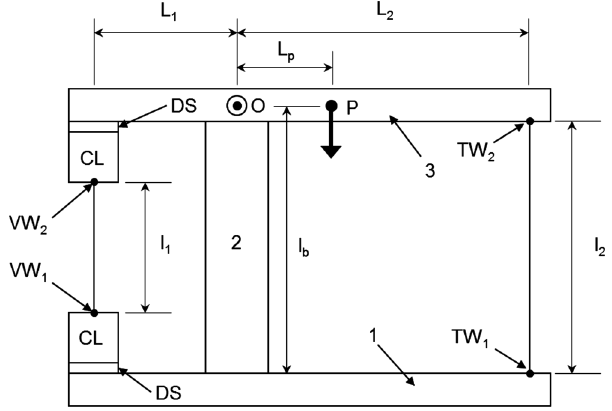
FIG. 2. Simplified drawing of the LA-VWM. 1: unmovable arm; 2: balancing arm support; 3: balancing arm. The thick arrow at point P denotes the direction of weight of the balancing arm applied to its center of gravity. The following notations are used in the text: l 1 : length of vibrating wire (distance between points VW 1 and VW 2 ); l 2 : length of target wire (distance between points TW 2 and TW 2 ); l b : length of balancing arm support (vertical distance between point TW 1 and balancing arm axis O); L 1 : horizontal distance between vibrating wire and point O; L 2 : horizontal distance between target wire and point O; horizontal distance between center of gravity of balancing arm (point P) and arm axis (point O), l k — vertical distance between points TW 2 and O; l p : total thickness of dielectric spacers (DS); l z : total length of vibrating wire clips CL. The target wire length l 2 is 60 mm, and 100% of the wire is available as a target for the beam